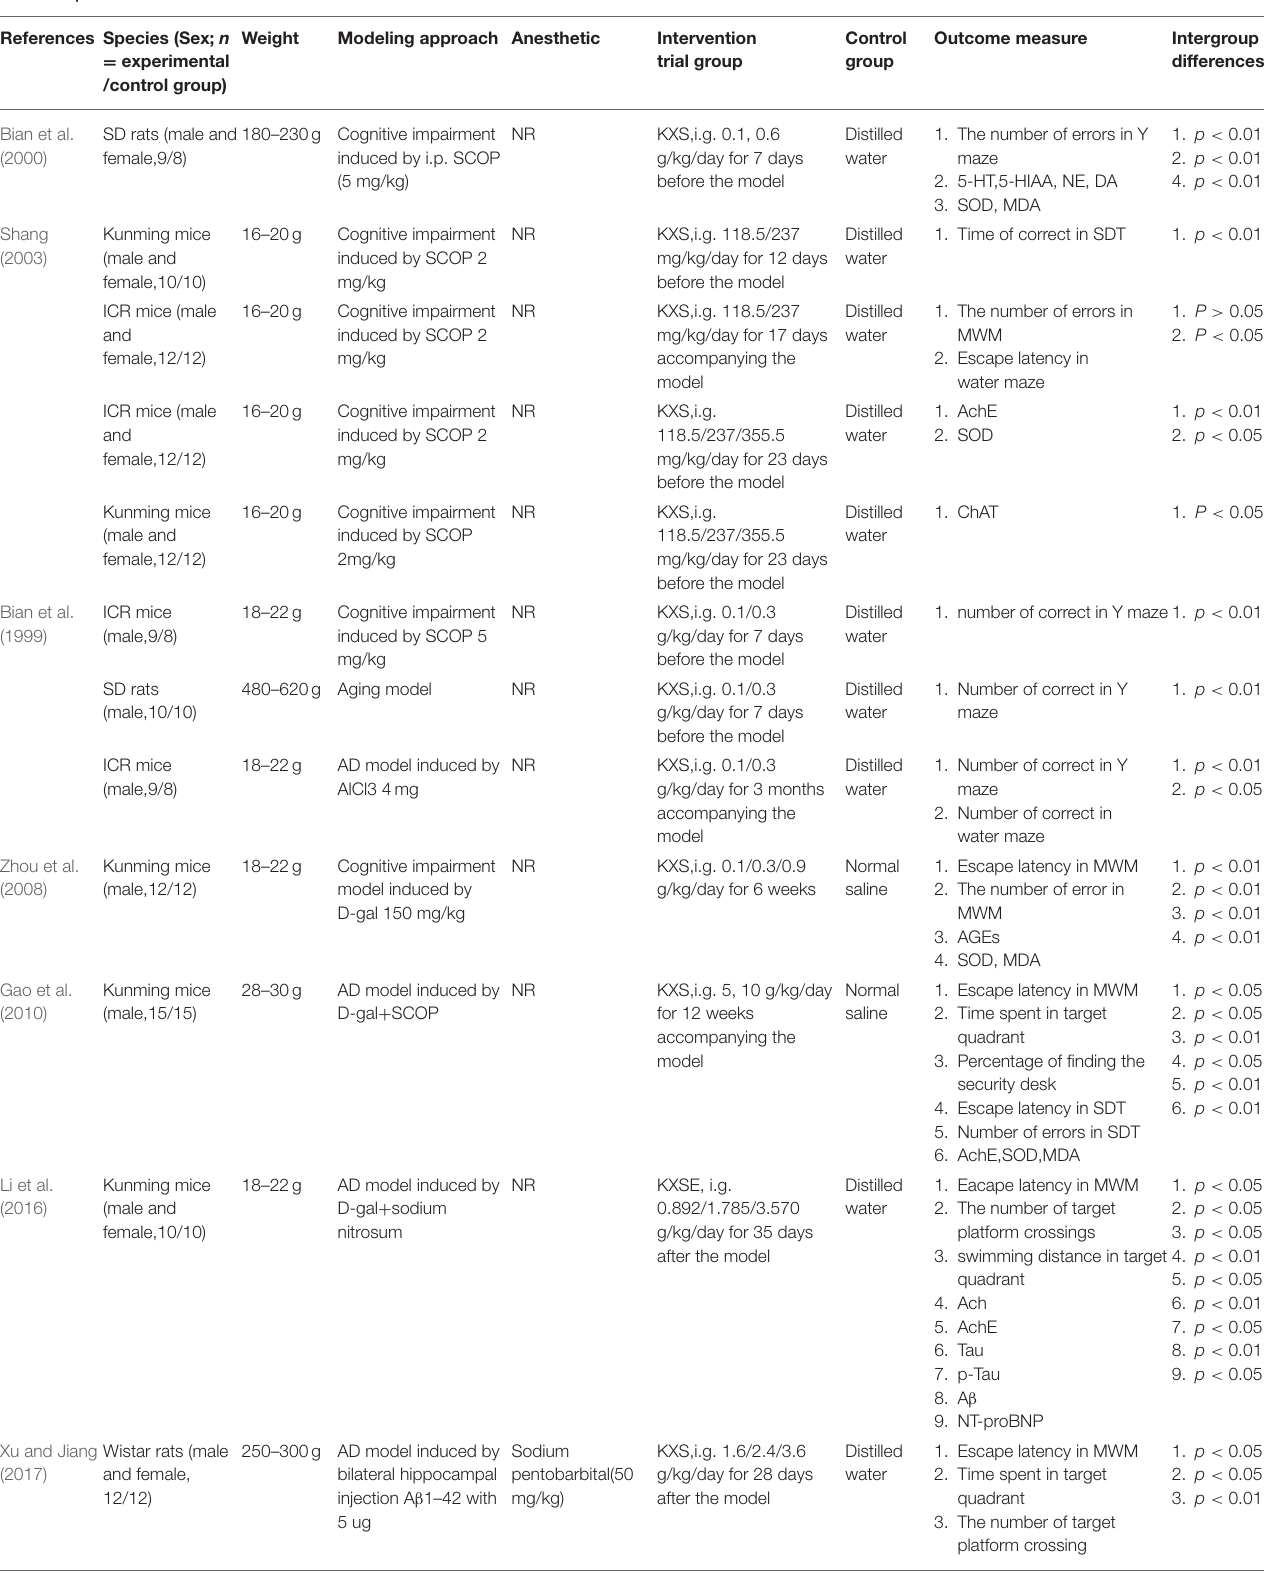
TABLE 1 | Characteristics of the 38 included